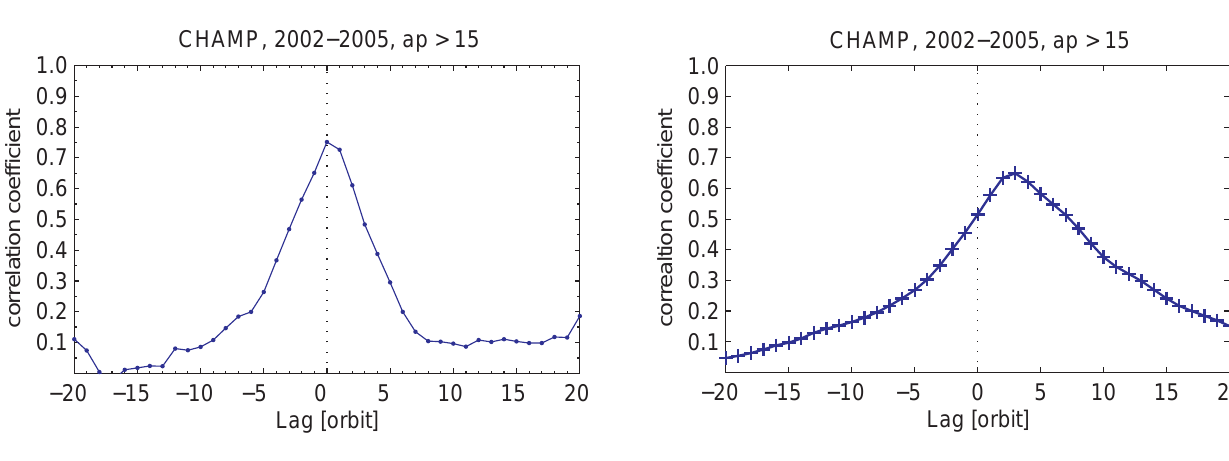
Fig. 9. Cross-correlation between the density readings on the day and night side for magnetically active 3-h intervals ( a p > 15). Posi- tive lags indicate a delayed response on the night side.